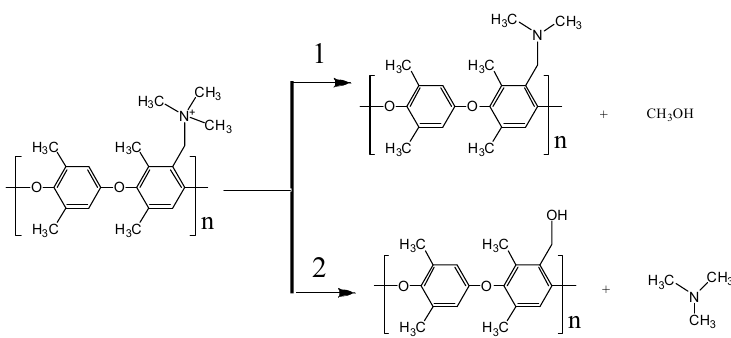
Figure 8. Degradation mechanism in PPO-3C 1 hydrated membrane observed in ReaxFF simulations.